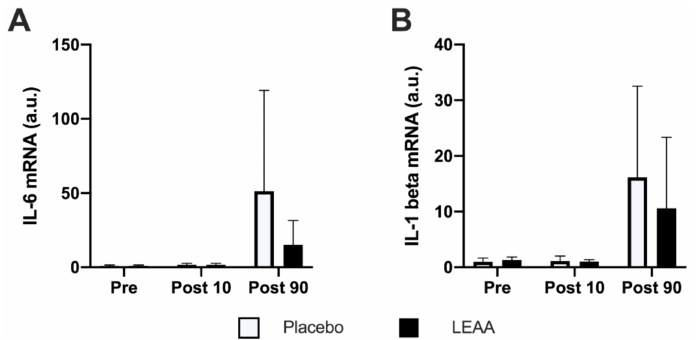
Figure 6. The mRNA expression of inflammatory cytokines. The mRNA expression of ( A ) IL-6 and ( B ) IL-1 β . The data are expressed relative to the pretreatment condition in the placebo group as the mean ± SD. The data were analyzed using ANCOVA adjusted for baseline values. No significant di ff erence was observed between the groups at each time